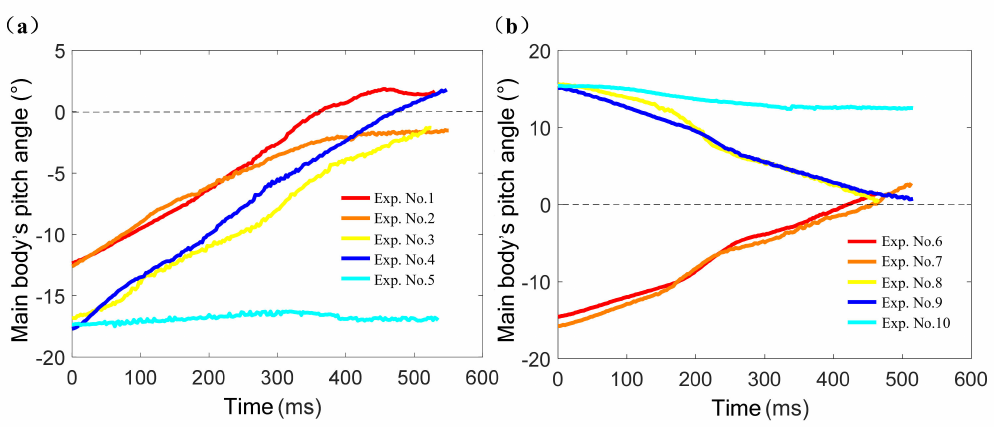
Figure 10. The jumping robot’s pitch angle curves of aerial pitch control experiment. ( a ) The pitch angle curves of Group 1. ( b ) The pitch angle curves of Group